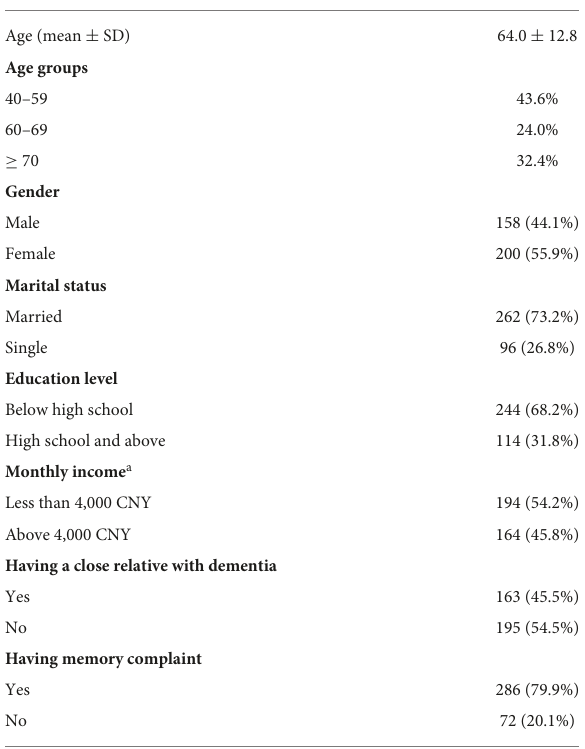
TABLE 1 The characteristics of the respondents ( N =